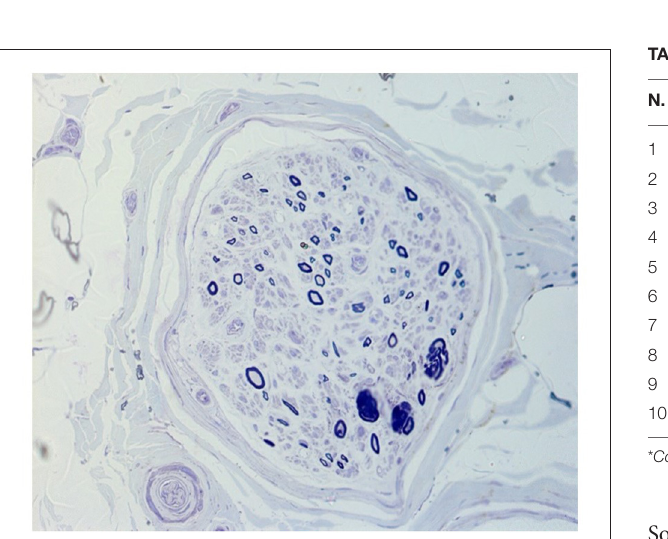
FIGURE 3 | Transverse semithin section stained with toluidine blue of fascicule from a sural nerve biopsy (pt. 7) showing a severely reduced density of myelinated fibers and axonal degeneration.